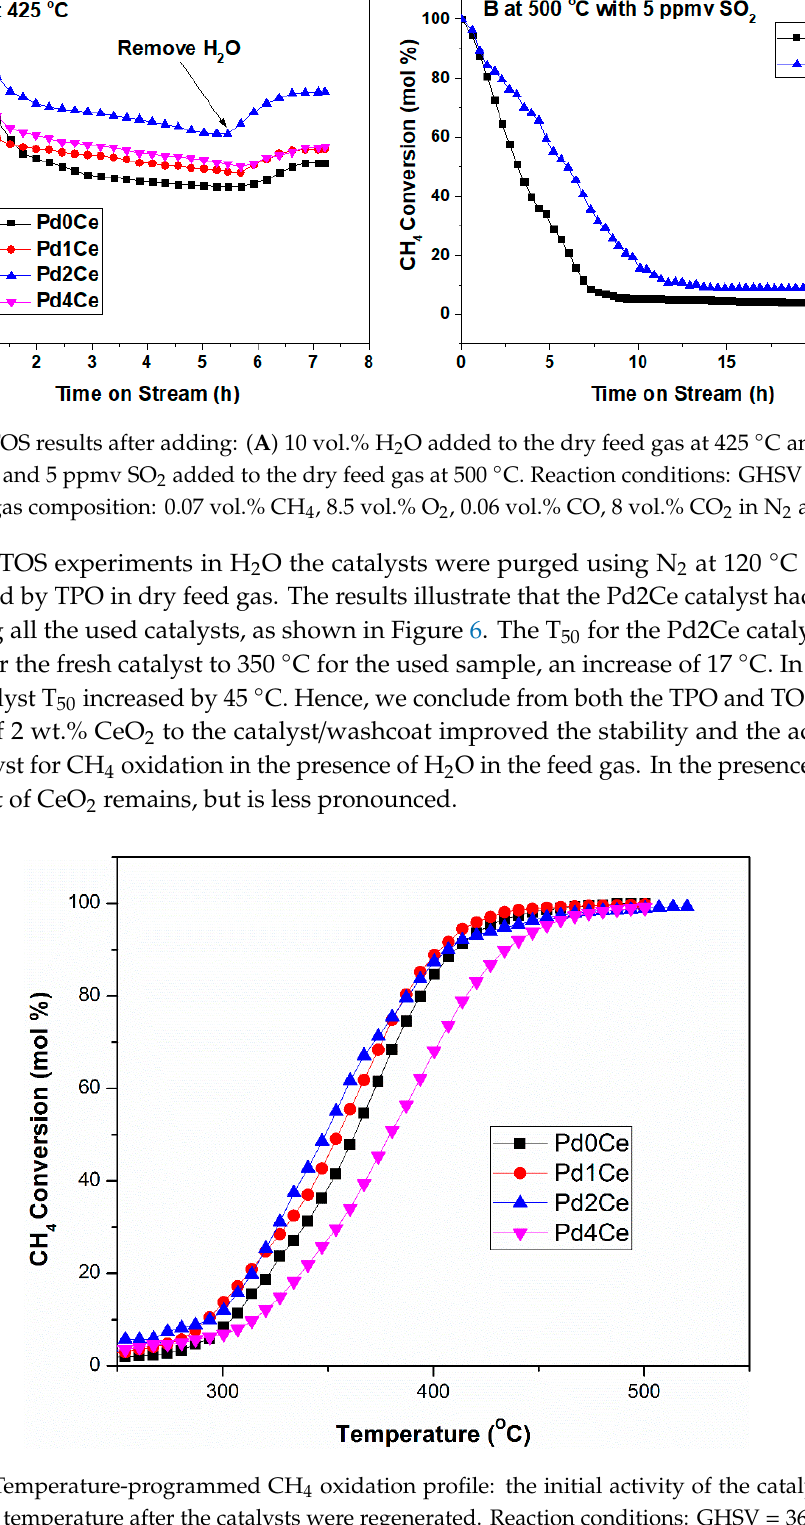
Figure 6. Temperature-programmed CH 4 oxidation profile: the initial activity of the catalysts as a function of temperature after the catalysts were regenerated. Reaction conditions: GHSV = 36,000 h − 1 , Feed gas composition: 0.07 vol.% CH 4 , 8.5 vol.% O 2 , 0.06 vol.% CO and 8 vol.% CO 2 in N 2 and He.